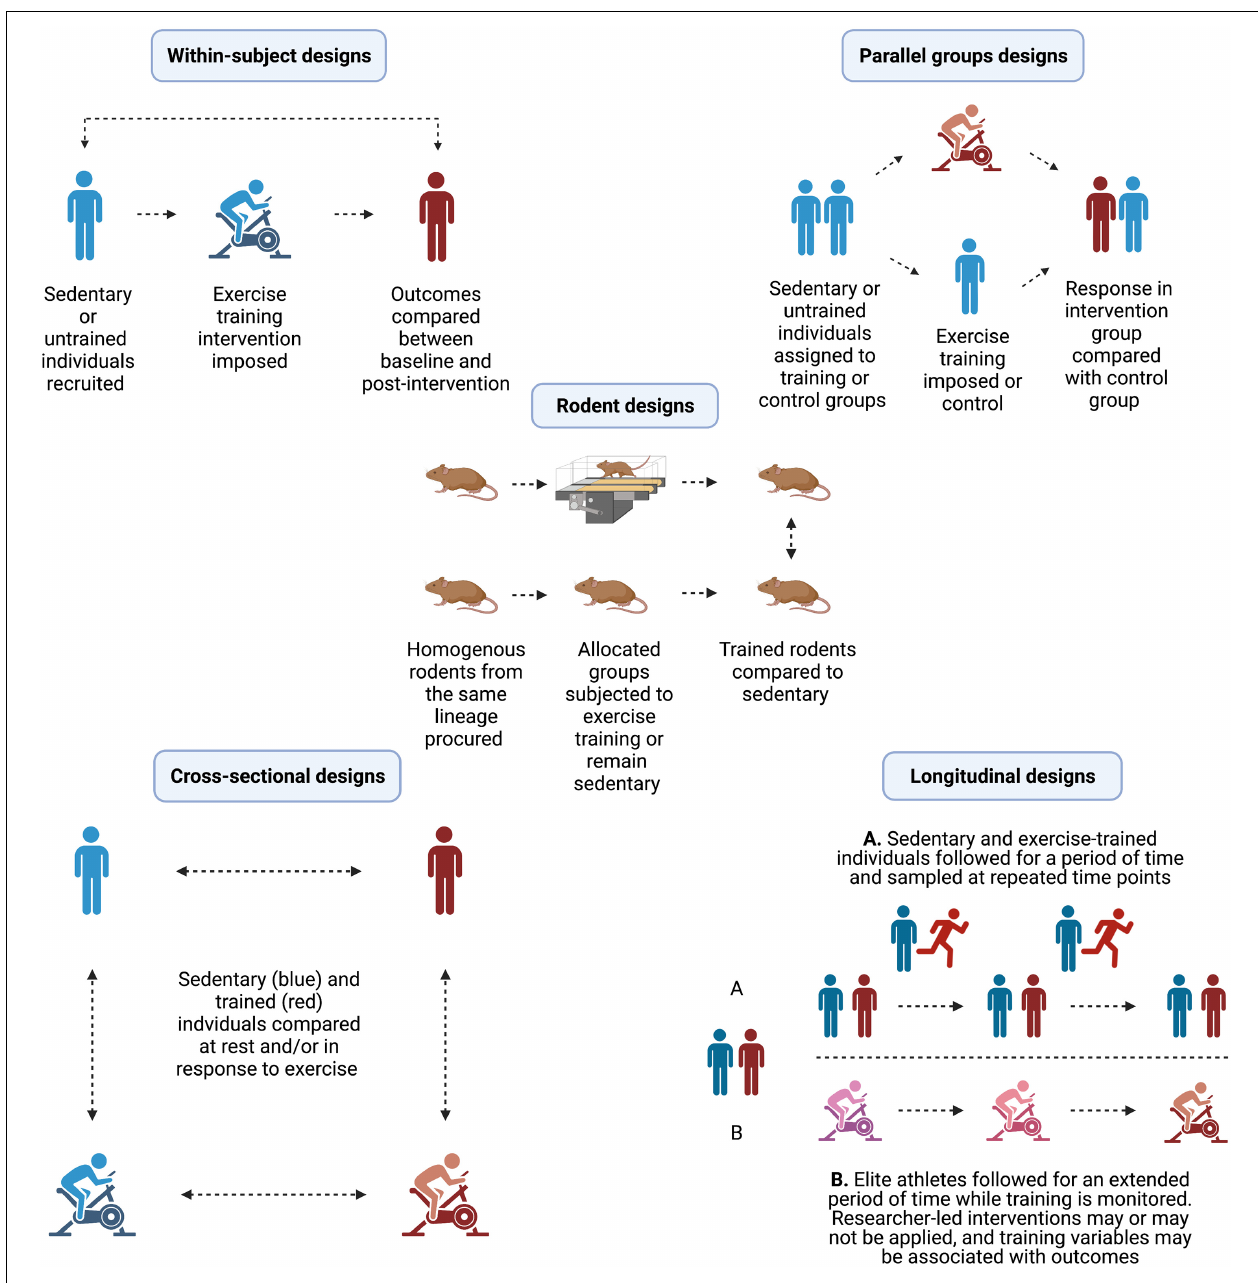
FIGURE 1 | Overview of study designs used to investigate the effect of exercise training on physiological and/or performance